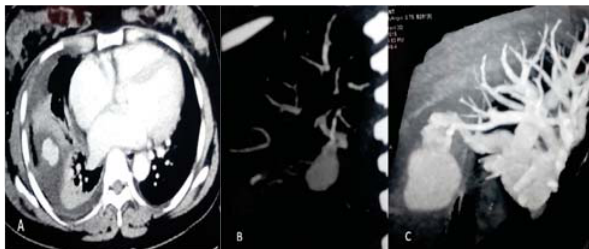
Figure 1. Contrast enhanced CT (A) showing contrast (cid:191)(cid:79)(cid:79)(cid:72)(cid:71)(cid:3) (cid:82)(cid:89)(cid:68)(cid:79)(cid:3) (cid:86)(cid:87)(cid:85)(cid:88)(cid:70)(cid:87)(cid:88)(cid:85)(cid:72)(cid:3) (cid:90)(cid:76)(cid:87)(cid:75)(cid:3) (cid:68)(cid:71)(cid:77)(cid:68)(cid:70)(cid:72)(cid:81)(cid:87)(cid:3) (cid:68)(cid:87)(cid:72)(cid:79)(cid:72)(cid:70)(cid:87)(cid:68)(cid:86)(cid:76)(cid:86)(cid:3) (cid:76)(cid:81)(cid:3) (cid:85)(cid:76)(cid:74)(cid:75)(cid:87)(cid:3) (cid:79)(cid:82)(cid:90)(cid:72)(cid:85)(cid:3)(cid:79)(cid:82)(cid:69)(cid:72)(cid:3)(cid:68)(cid:81)(cid:71)(cid:3)(cid:85)(cid:76)(cid:74)(cid:75)(cid:87)(cid:3)(cid:83)(cid:79)(cid:72)(cid:88)(cid:85)(cid:68)(cid:79)(cid:3)(cid:72)(cid:3445)(cid:88)(cid:86)(cid:76)(cid:82)(cid:81)(cid:17)(cid:3)(cid:38)(cid:55)(cid:3)(cid:68)(cid:81)(cid:74)(cid:76)(cid:82)(cid:74)(cid:85)(cid:68)(cid:83)(cid:75)(cid:92)(cid:3)(cid:11)(cid:37)(cid:3) and C) showing shunting of branch of right descending pulmonary artery and right inferior pulmonary vein